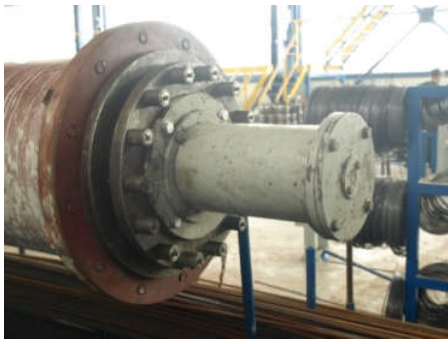
Figure 1. Little mould attached to steel mould used for manufacturing spun concrete power poles.